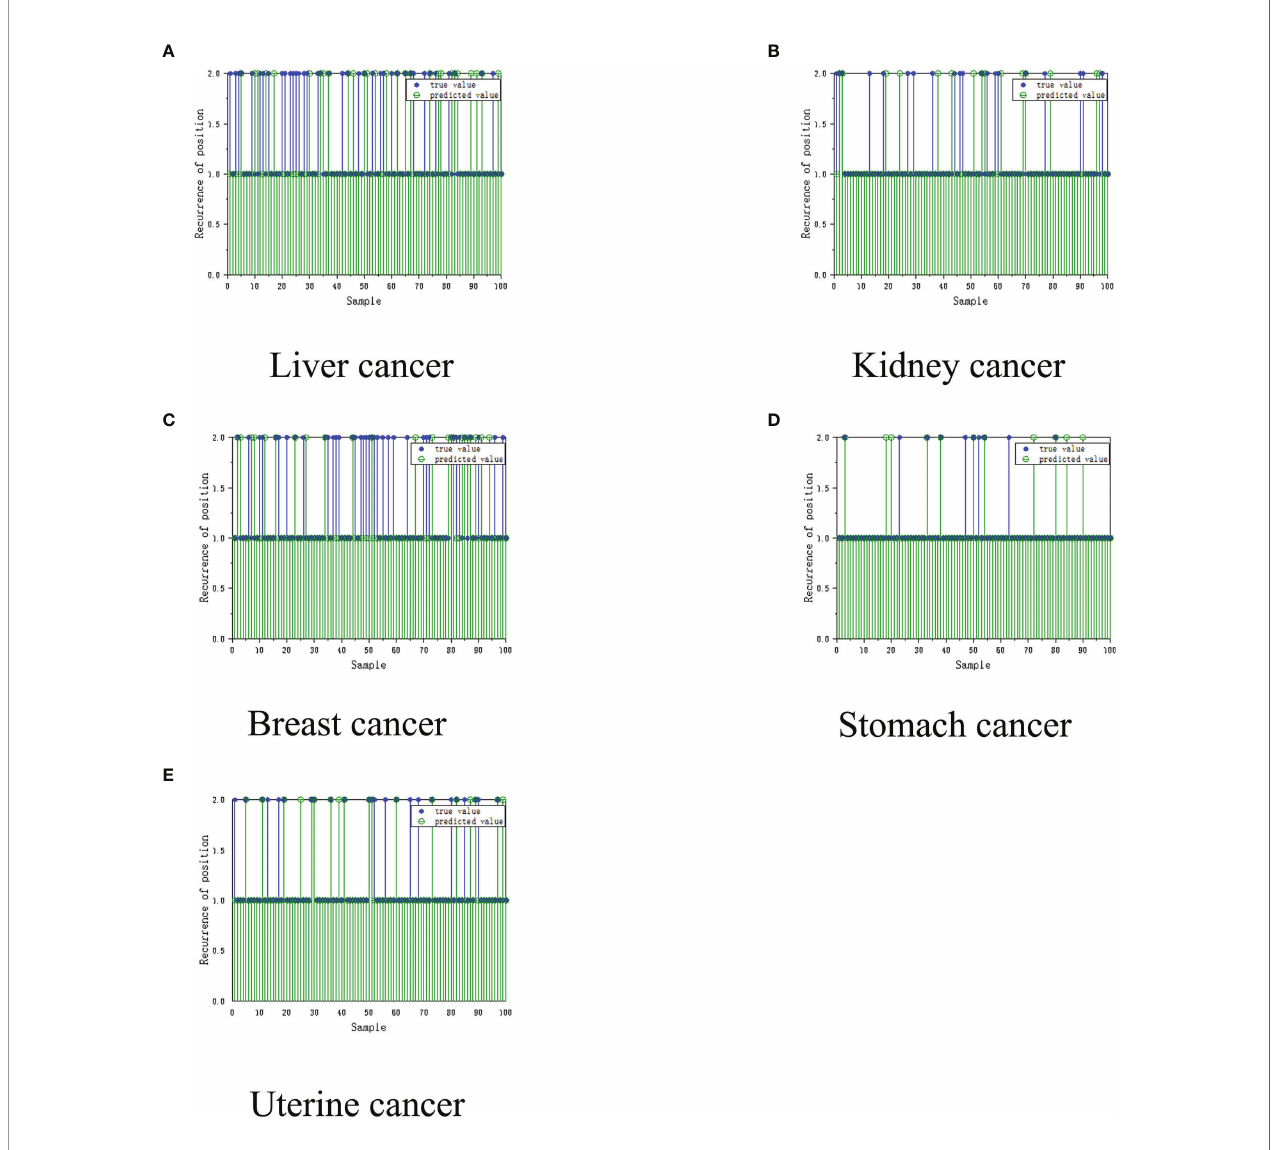
FIGURE 5 | Recurrence location model for cancer assisted diagnosis based on machine learning. (A) Liver cancer. (B) Kidney Cancer. (C) Breast cancer. (D) Stomach cancer. (E) Uterine cancer.